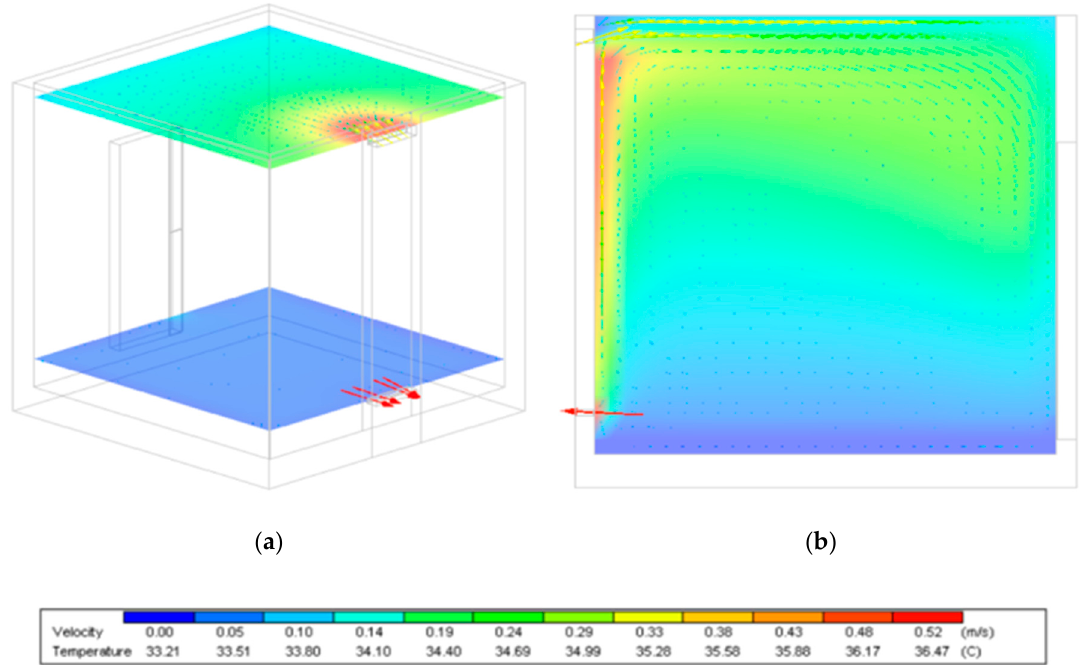
Figure 9. CFD (computational fluid dynamics) analysis (air velocity and temperature) of module 2 (with a Trombe wall): ( a ) Horizontal planes at vent levels; ( b ) Vertical plane in front of the Trombe wall.